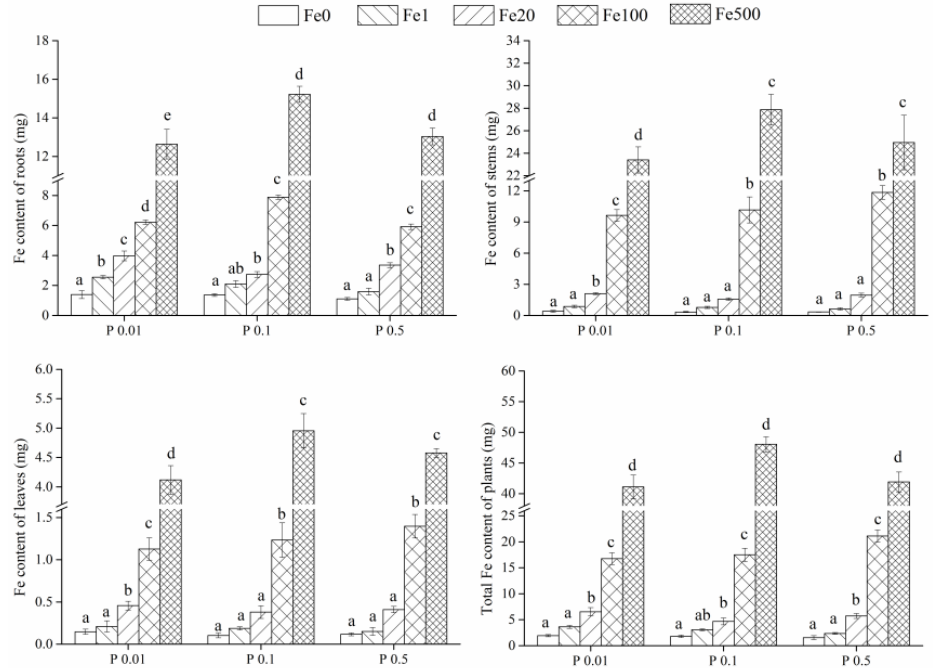
Figure 4. Effects of Fe 2+ and P on roots, stems, leaves, and total Fe contents of G. spiculosa . Values (mean ± SE, n = 3) followed by different letters designate significant differences ( p < 0.05) between Fe 2+ concentrations for a given P level (a, b, c, d).